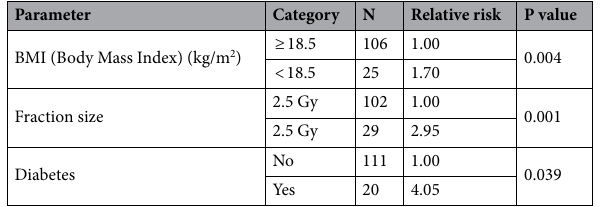
Table 5. The results of multivariate analysis of correlations between selected prognostic factors and risk of disease-specific survival.